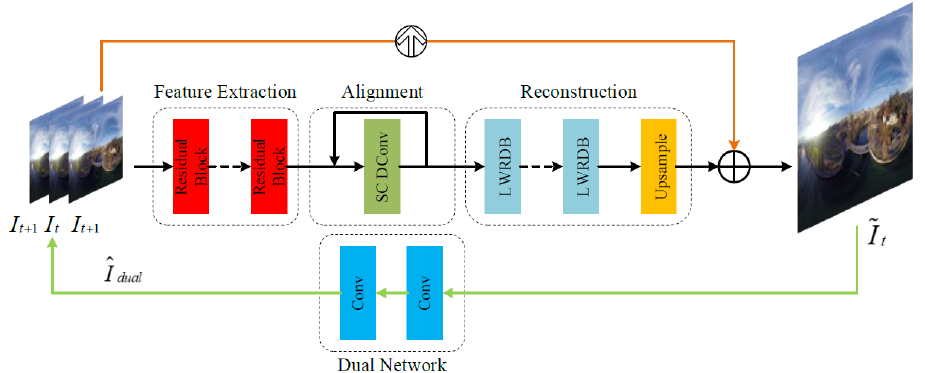
Figure 1. The network architecture of the proposed LWPVSR method. Our LWPVSR method mainly consists of the four modules: the feature extraction module, the feature alignment module, the reconstruction module, and the dual network